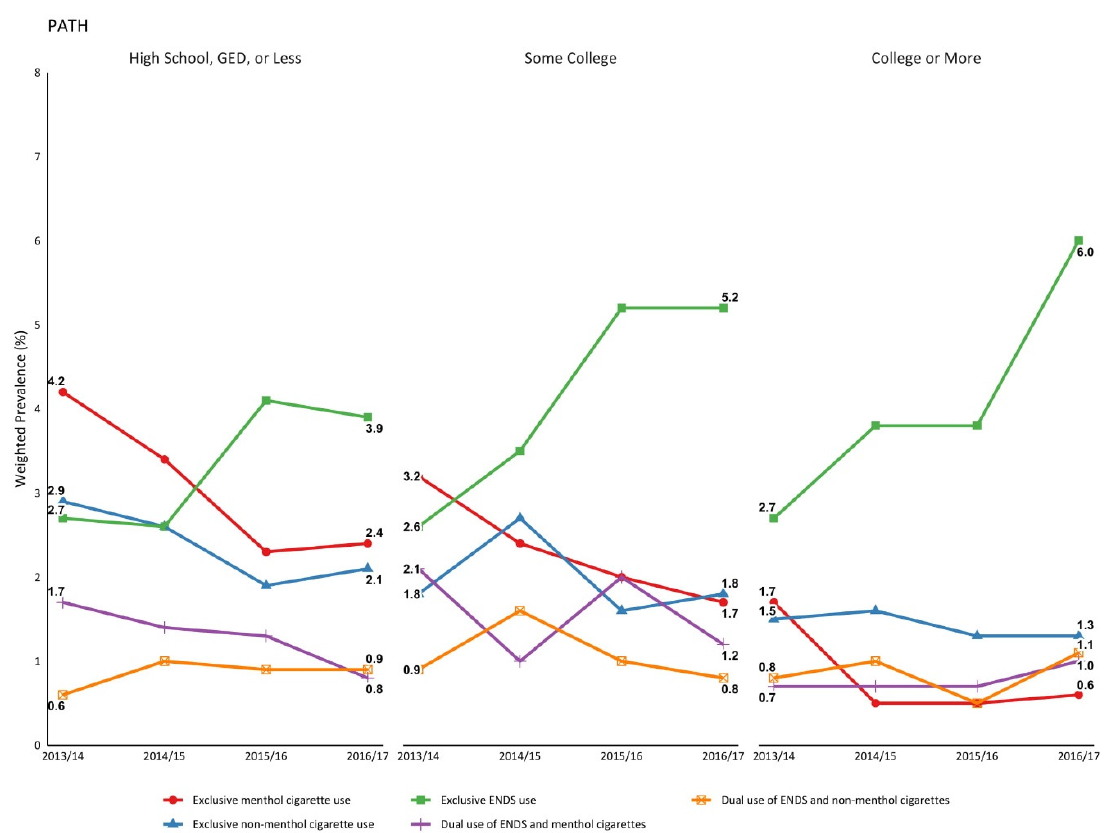
Figure 2. Prevalence of exclusive and dual use of ENDS and menthol/non-menthol cigarettes by parental education level in PATH.